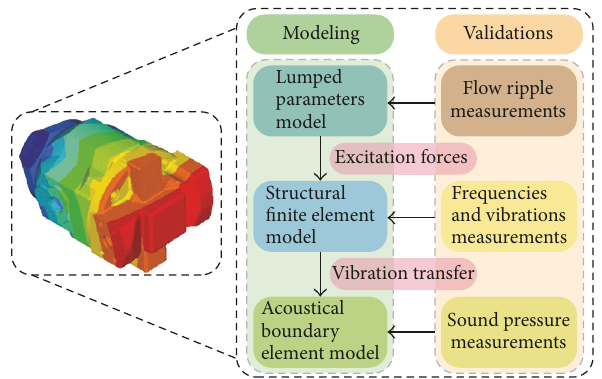
Figure 2: Methodology used to predict the vibroacoustic character- istics of the axial piston